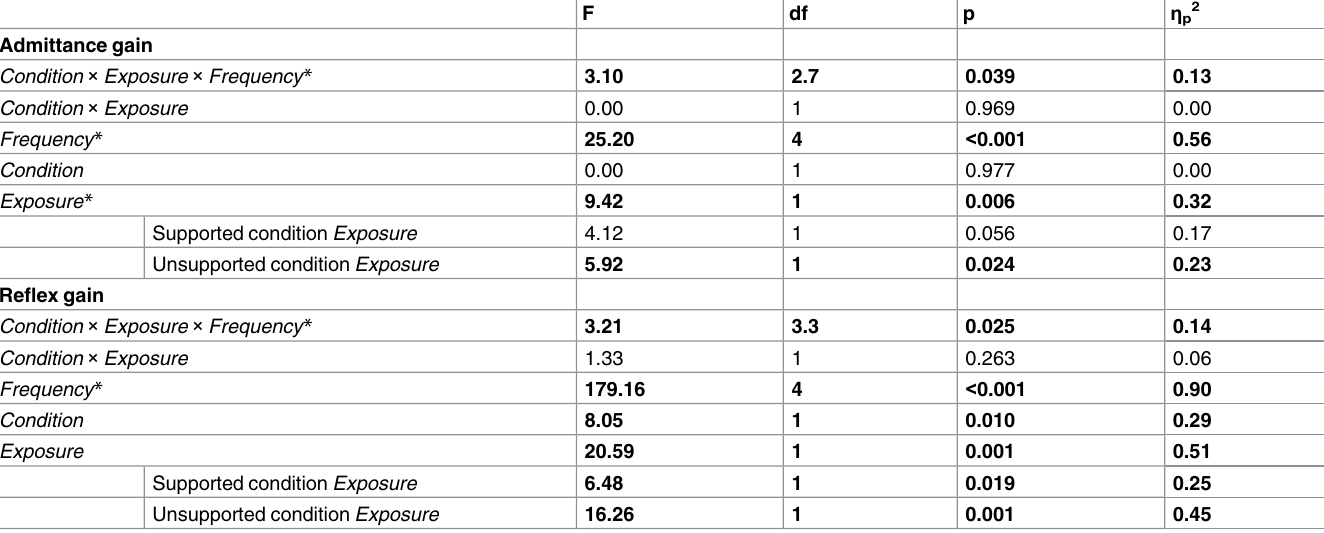
Table 3. Main and interaction effects of the RMANOVA for the gain of admittance and reflexes.